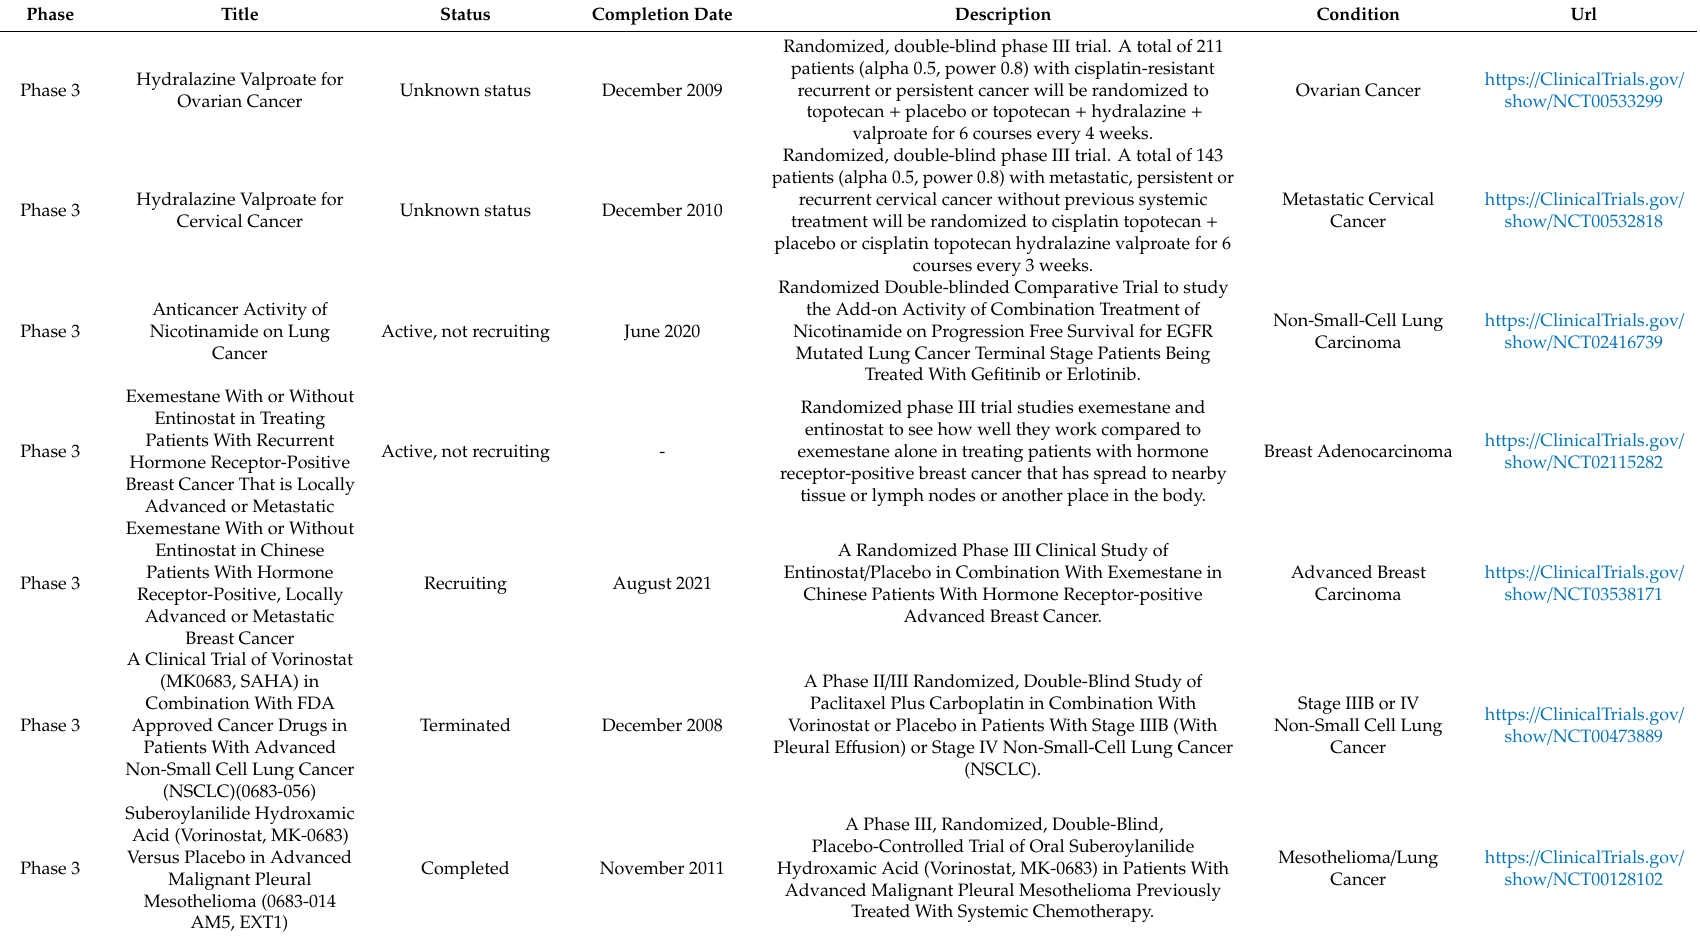
Table 3. Phase-III HDACi clinical trials: characteristics of Seven phase-III clinical trials registered in https: // clinicaltrials.gov / that involve